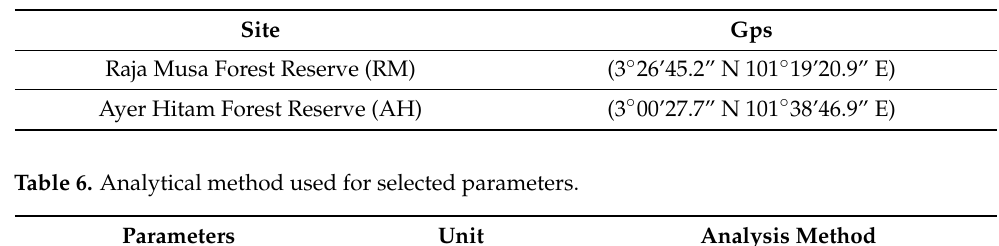
Table 5. Location of sample collections.